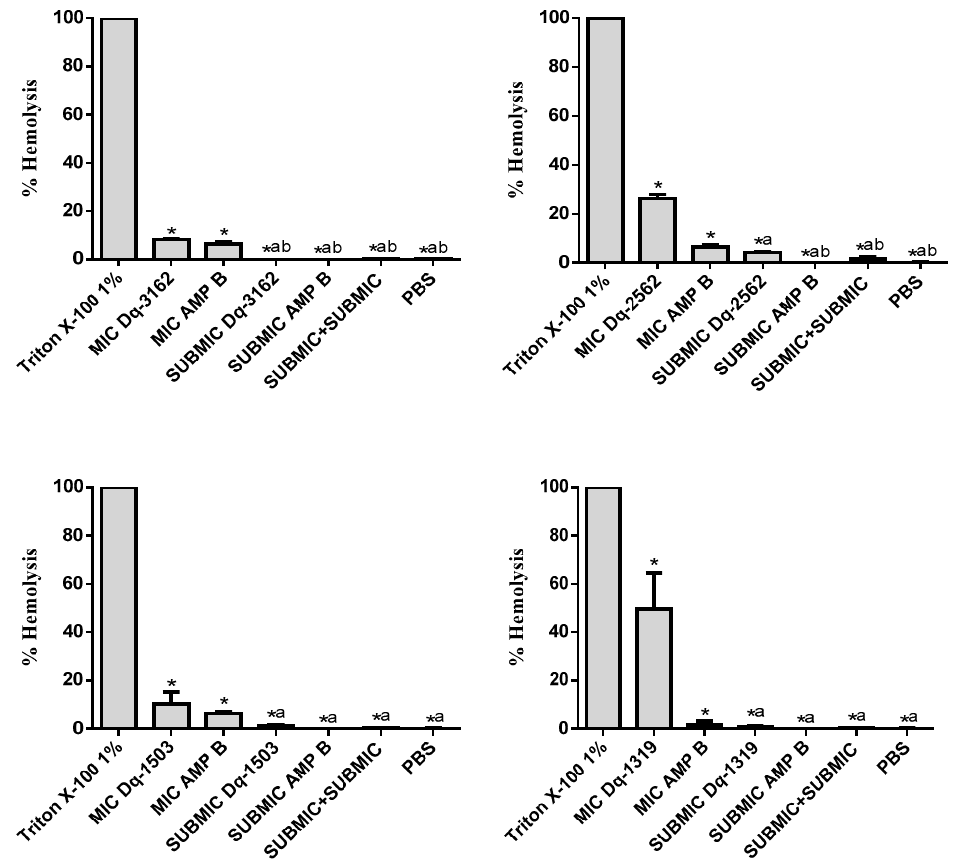
Figure 6. Percentage of hemolysis, in vitro , after exposure of human erythrocytes to combinations of pilosulin- (Dq-2562, Dq-1503, and Dq-1319) and ponericin-like (Dq-3162) peptides and amphotericin B. Human erythrocytes were treated as described in materials and methods. ANOVA and Tukey’s multiple comparisons test. * p < 0.05 (compared to 1% Triton X-100). a p < 0.05 (compared to the MICs of peptides). b p < 0.05 (compared to amphotericin B, AMP B, at the MIC).